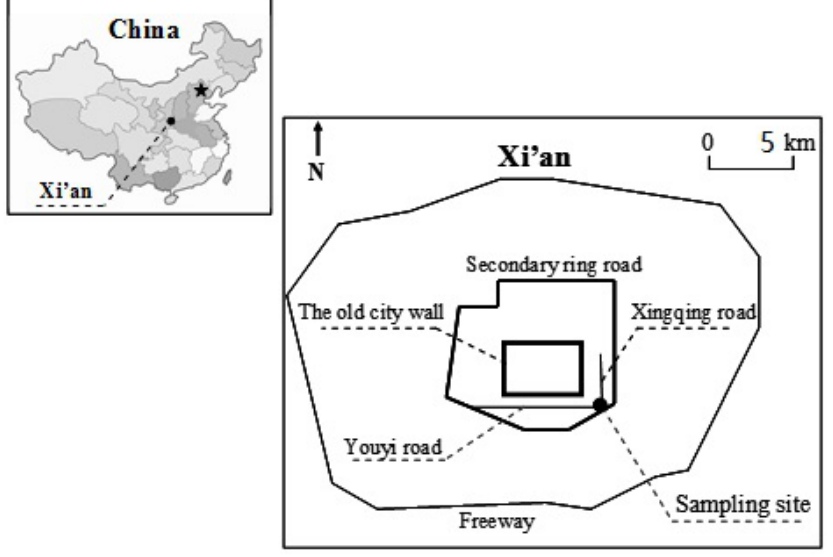
Figure 1. Location of sampling site.